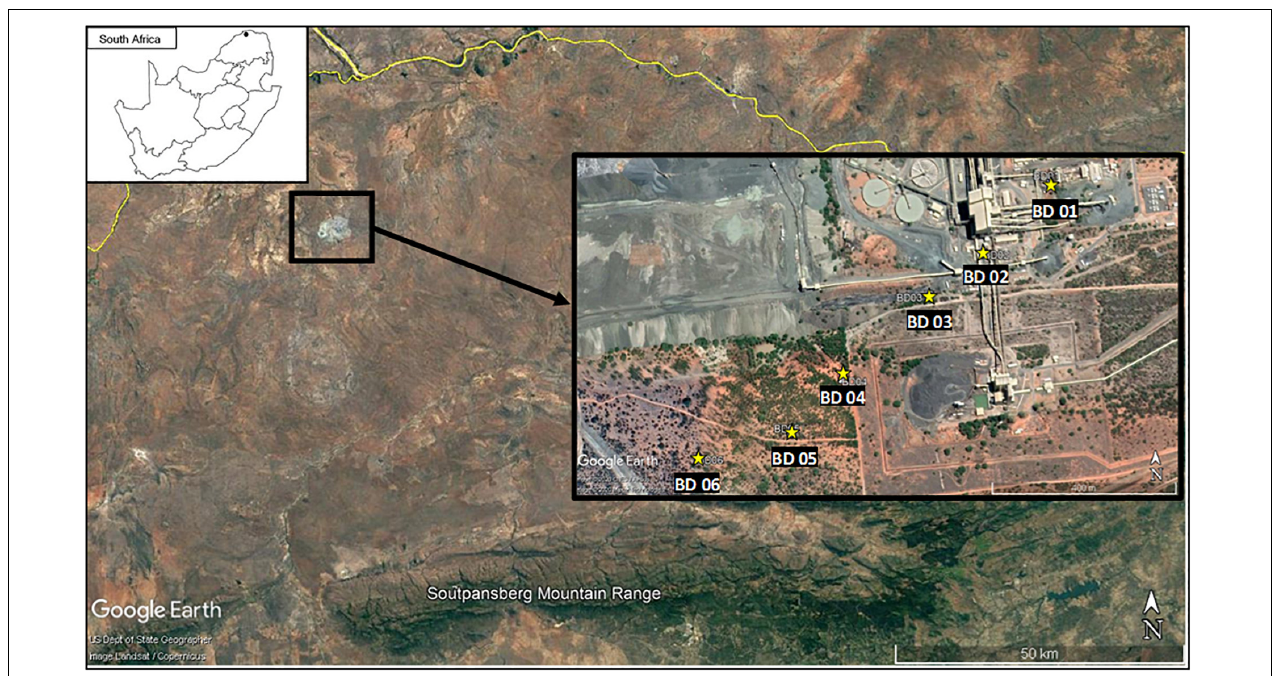
FIGURE 1 | The location of the study site in the northern Limpopo River Valley (dot on map insert) and placement of the bat detectors ( ) on the Venetia diamond mine. BD01 was situated at a workshop, BD02 was at the processing plant itself, BD03 was on the edge of a laydown (open-air storage) area, BD04 was placed along the edge of a road opposite the sorting area, BD05 and BD06 were place furthest from the noise and light of the active mining areas in natural vegetation.